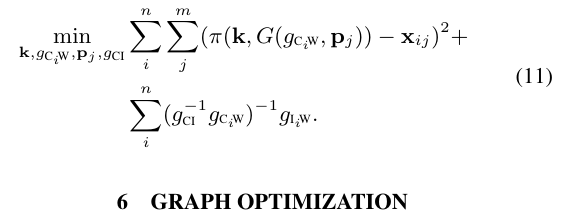
Figure 5: The objective function of the stated problem can be illustrated by a hyper-graph. The measurements (boxes) are pre- sented as links between the nodes concerning each multiple sets of variables (circles). For improved overview multiple state vari- ables and measurements of the same type are visualized in a stacked view unrelated to their number of